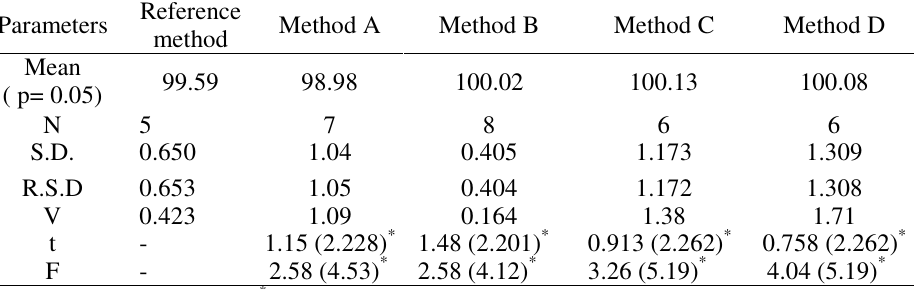
Table 4. Statistical data for the determination gabapentin using method (A-D) compared with reference method 4